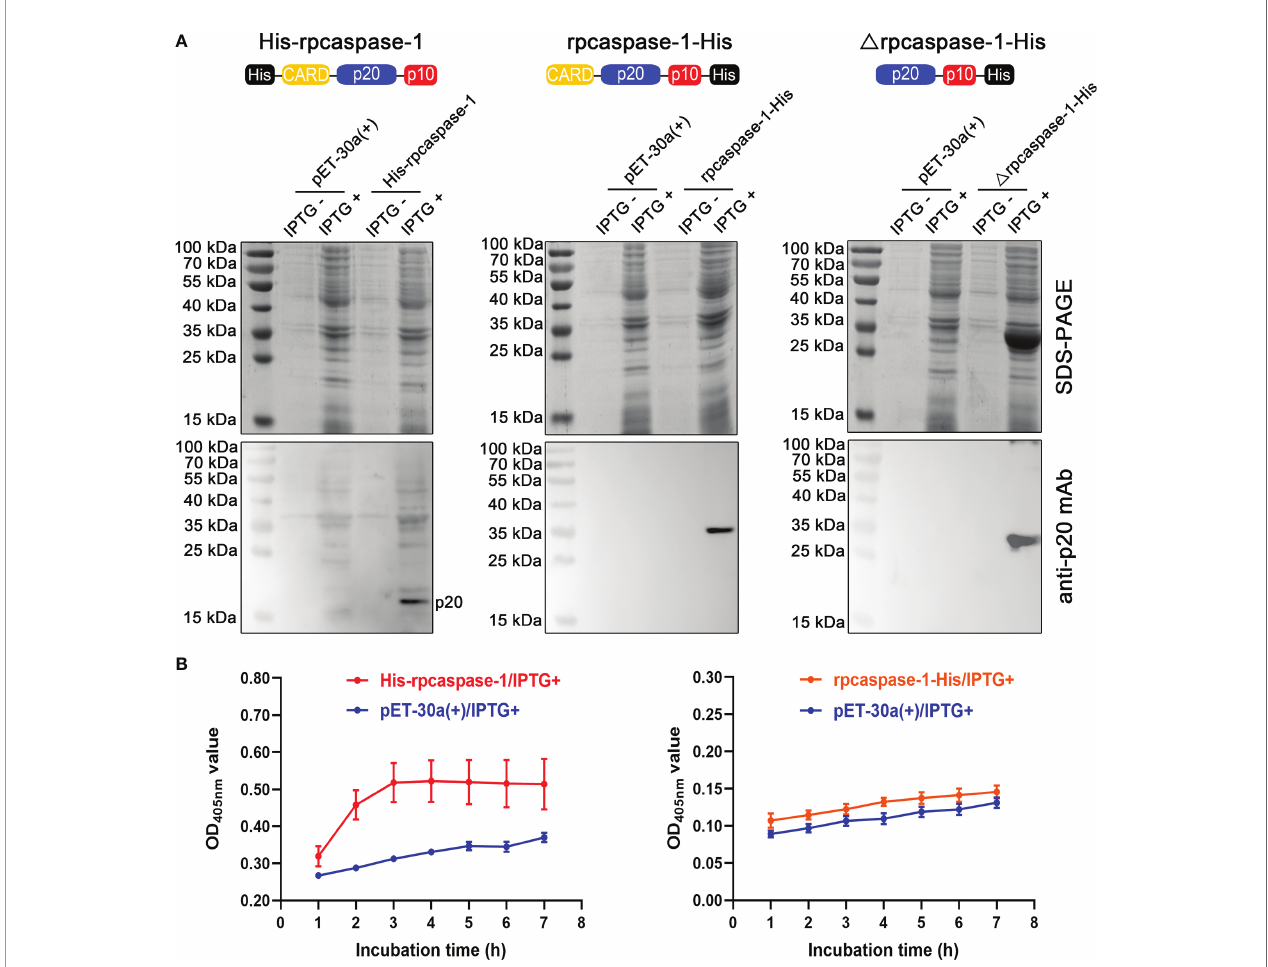
FIGURE 2 | Expression and determination of enzymatic activity of recombinant pcaspase-1. (A) Determination of the expression of His-rpcaspase-1, rpcaspase-1- His and D rpcaspase-1-His by SDS-PAGE and Western blot assays using anti-rpcaspase-1 p20 mAb. E.coli competent cells were transformed with either pET-30a (+), pET-30a(+)-His-pcaspase-1, pET-30a(+)-pcaspase-1-His or pET-30a(+)- D pcaspase-1-His. IPTG was added into the liquid cultures of the transformants. The liquid cultures without IPTG were used as background controls. (B) The enzymatic activity of His-rpcaspase-1 and rpcaspase-1-His was determined by incubating the E. coli lysates containing the recombinant proteins with Ac-YVAD- p NA(a caspase-1substrate) and measuring the OD 405 nm values of the mixtures. Results shown are means from three technical